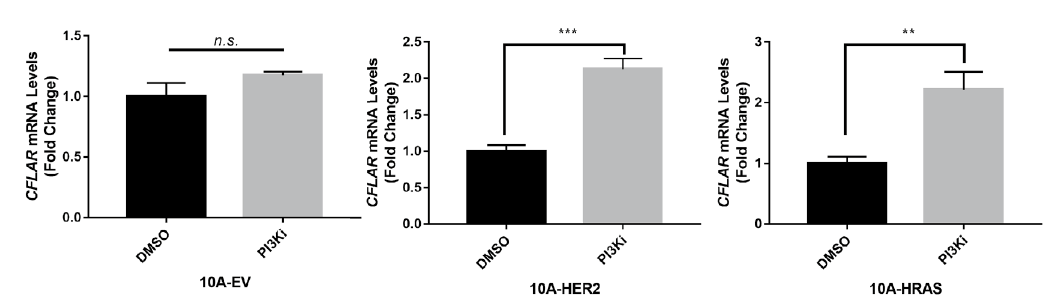
aggressive, triple negative breast cancer line (Fig. 5C). Indeed, c-FLIP L compromised the viability of these cells when grown in ECM-detached conditions (Fig. 5D). Similarly, when cells were grown in ECM-detachment and then re-plated at low density in ECM-attached conditions, c-FLIP L expression blocked the capacity of these cells